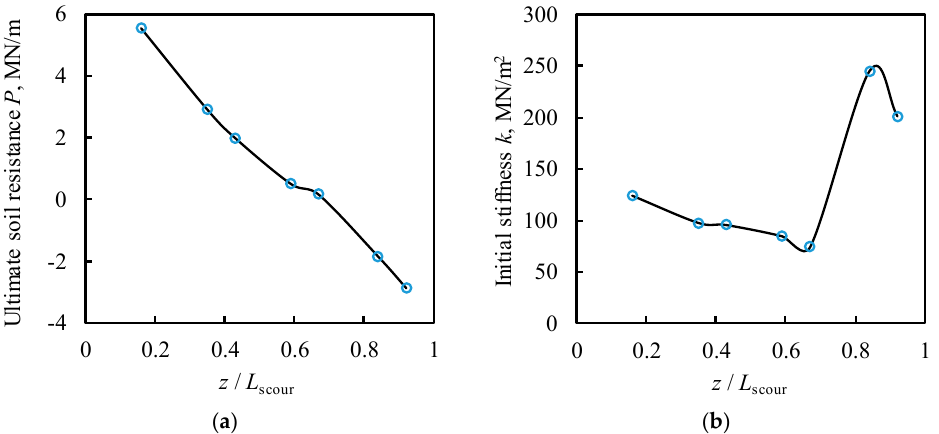
Figure 9. P and k values calculated from the ABAQUS numerical model: ( a ) Ultimate soil resistance, ( b ) Initial stiffness.